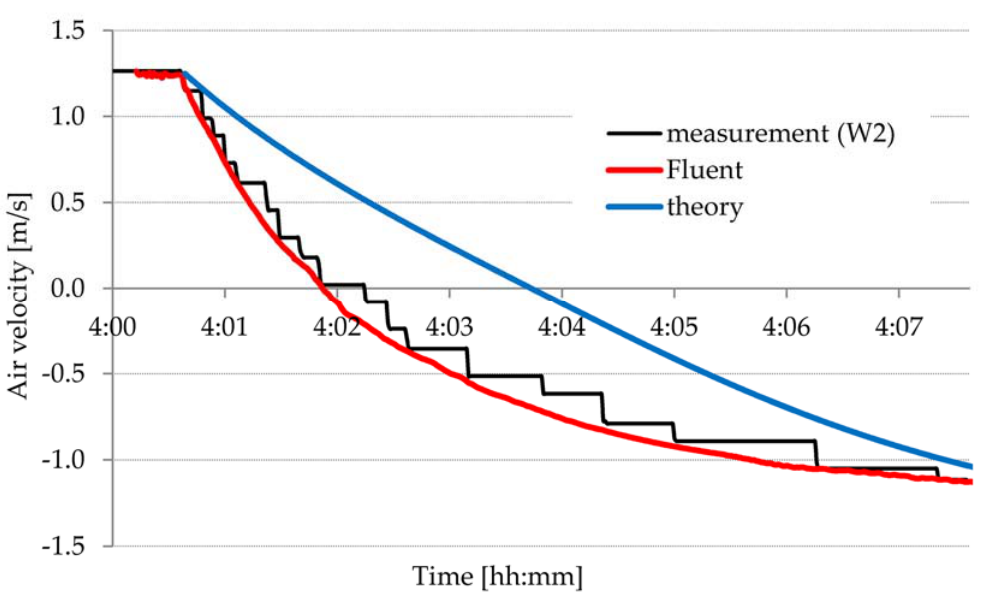
Figure 7. Transient case 2: “0” → “1 rev”.